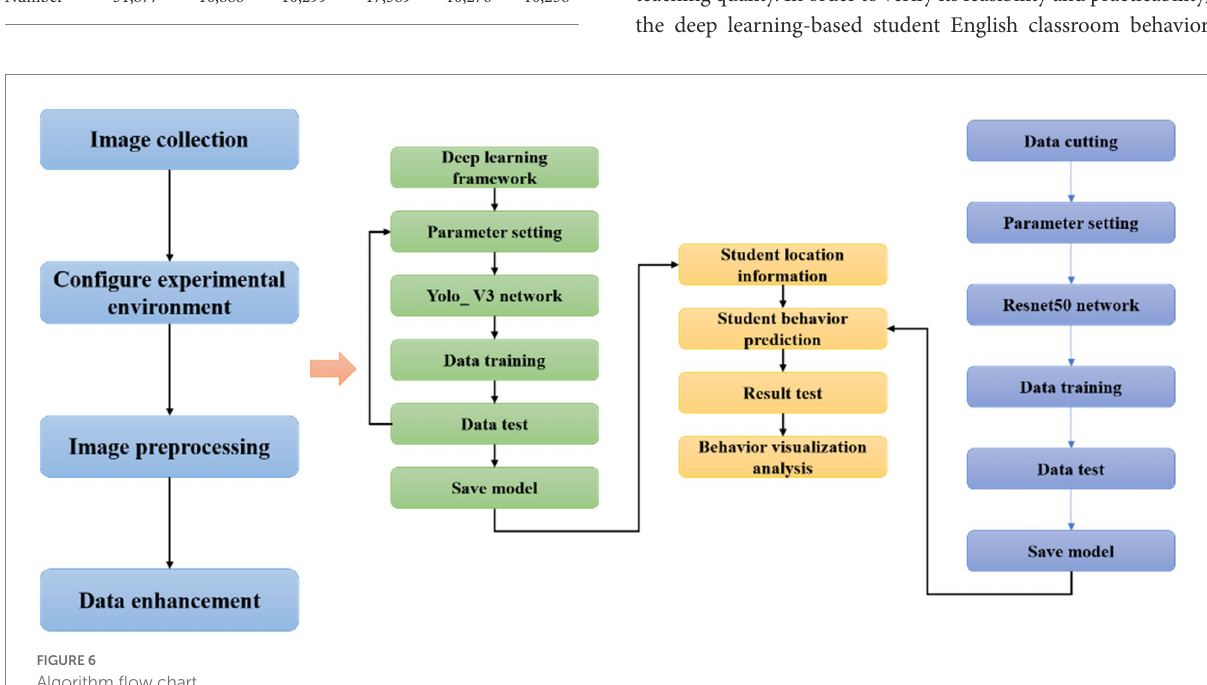
FIGURE 6 Algorithm flow chart.